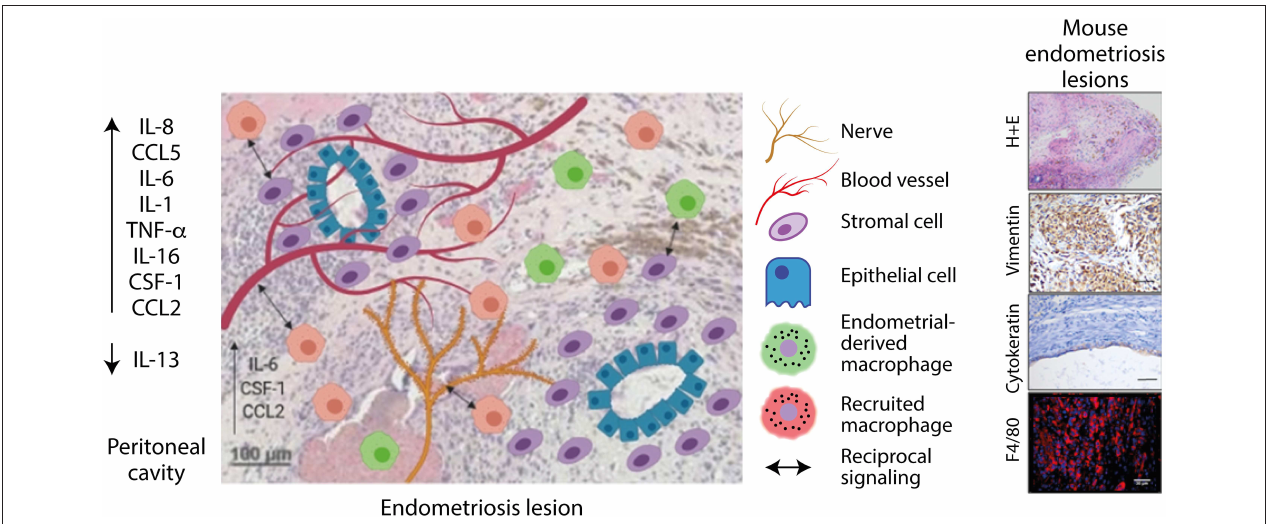
FIGURE 3 | Endometriosis lesions are infiltrated by blood vessels, nerves, and macrophages. Lesion resident macrophages are derived from macrophages originating from the endometrium and recruited macrophages. Macrophages interact with blood vessels and nerves to stimulate their growth. Signaling also occurs between macrophages and stromal cells, which increases their clonal expansion and invasive properties. Created using Biorender.com.